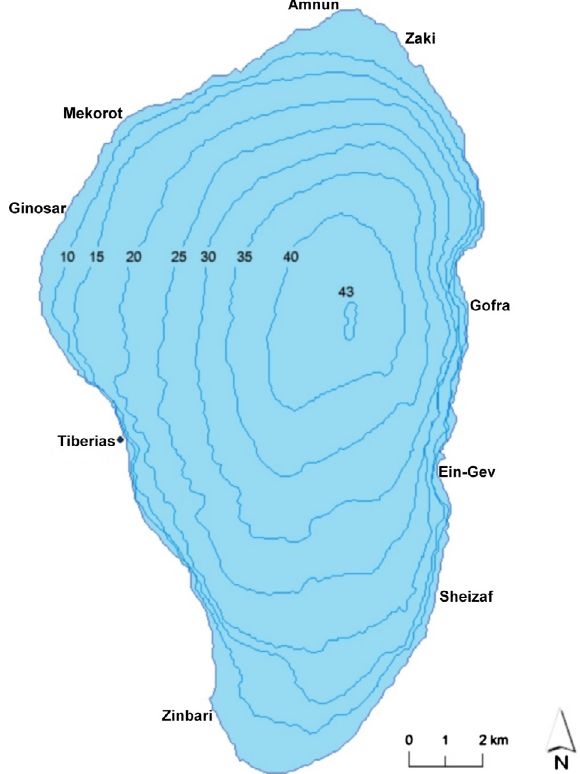
Figure 1. Lake Kinneret map: sampling